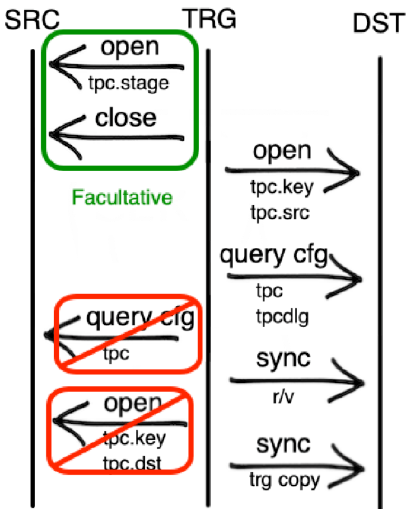
Figure 2 . Event sequence in the XRootD TPC Lite protocol. The steps to establish rendezvous point (in Fig. 1) is removed. The CGI key dpc.dlg=1 indicates that client credential will be delegated (also an indication that the destination server should perform according to the TPC Lite protocol). The tpc.key will be